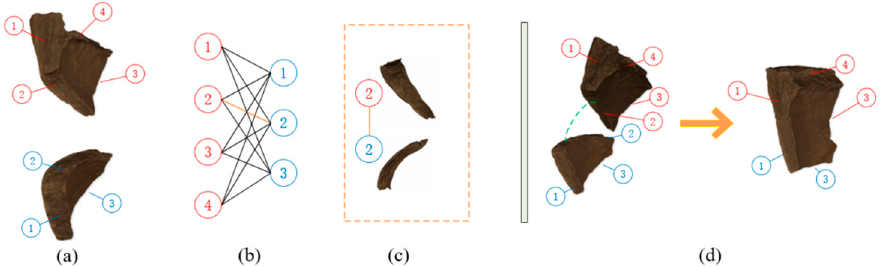
Figure 4. An example of calculating the similarity score of the fracture surface and select objects to be registered. ( a ) Two fragments and their fracture surfaces; ( b ) all potential matching pairs; ( c ) “2–2” match with the highest similarity score; ( d ) registration of pair “2–2”.